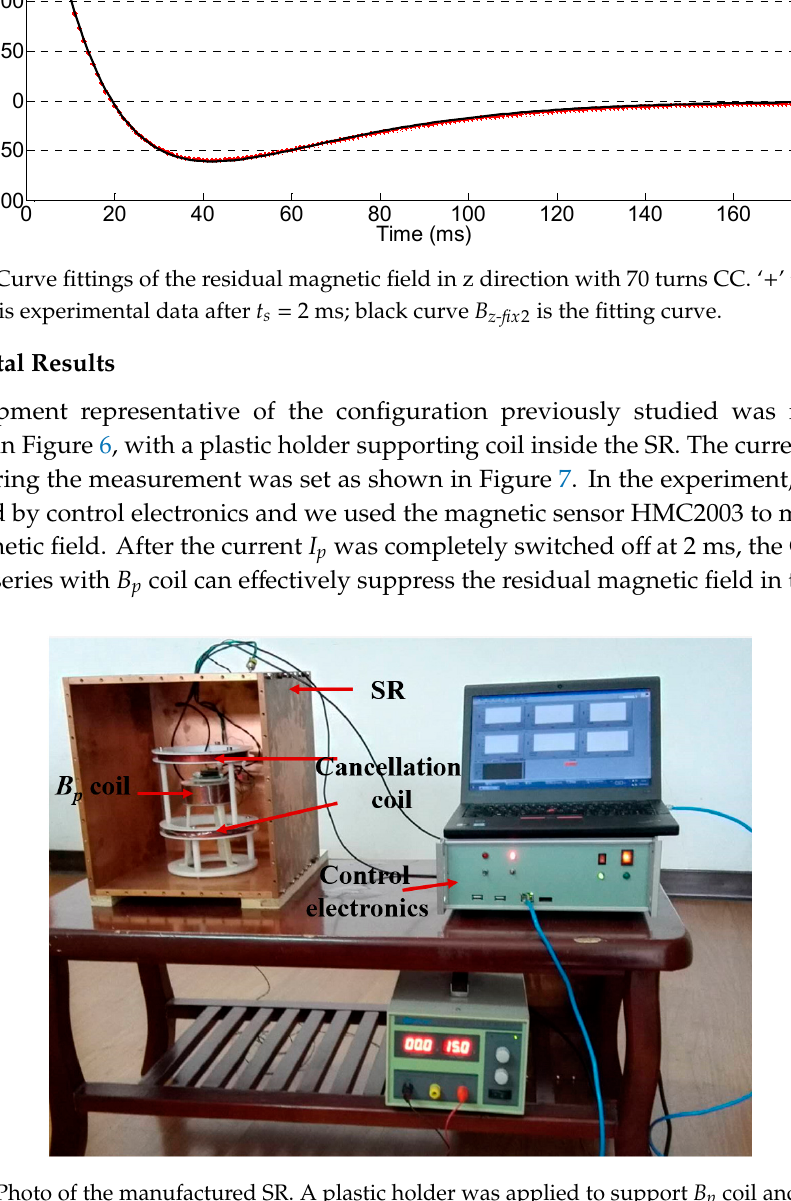
Figure 6. Photo of the manufactured SR. A plastic holder was applied to support B p coil and CC (front door of SR was temporarily removed). Considerable amounts of bolts were configured along the contact areas of the SR walls to better reduce the impedance of the eddy current.